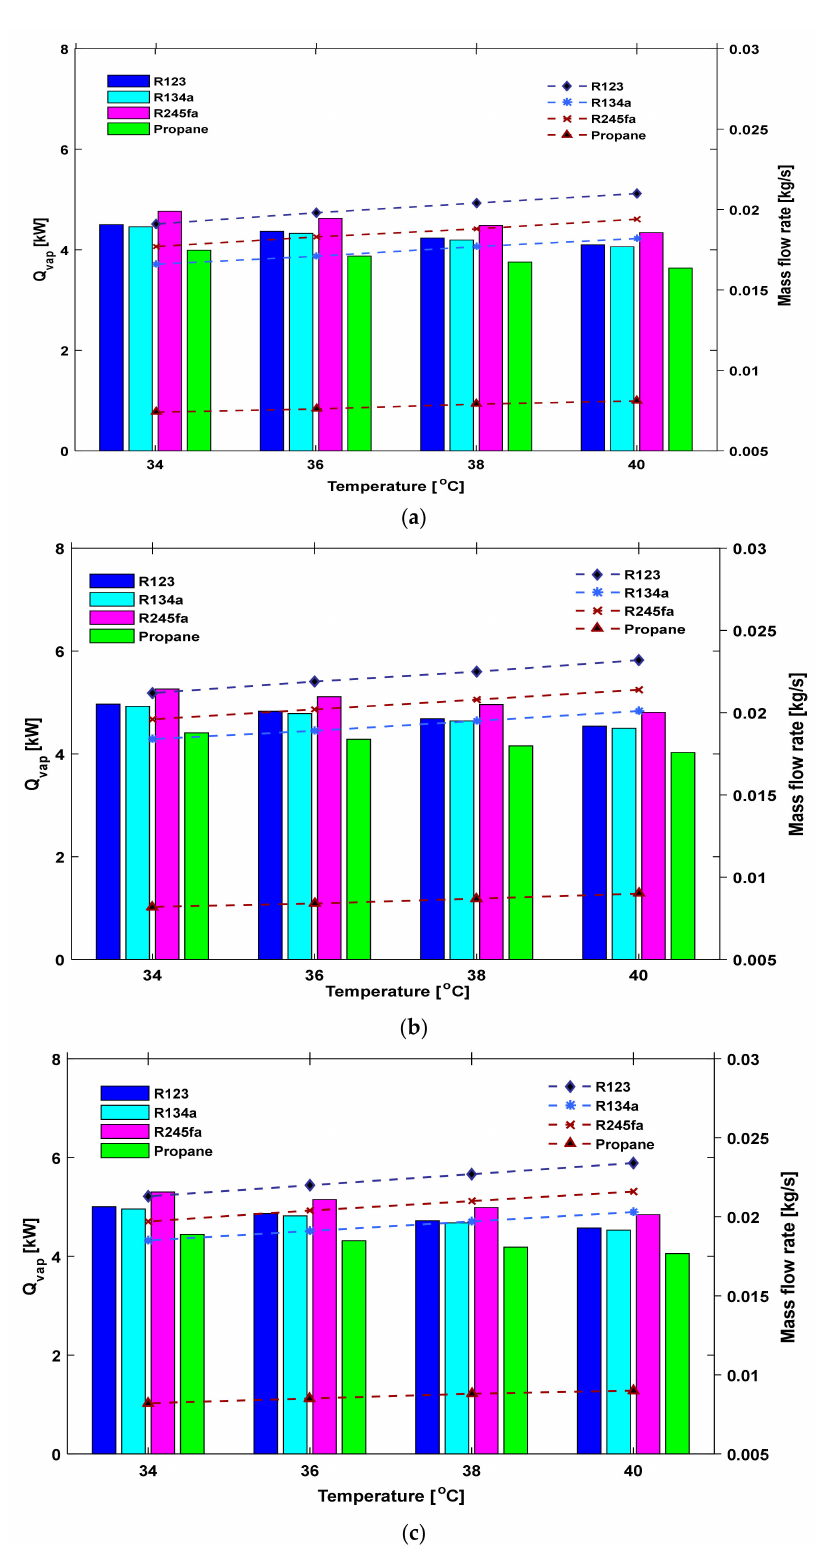
Figure 7. Scrutinized combinations with ( a ) R123, ( b ) R134a, and ( c ) R245fa